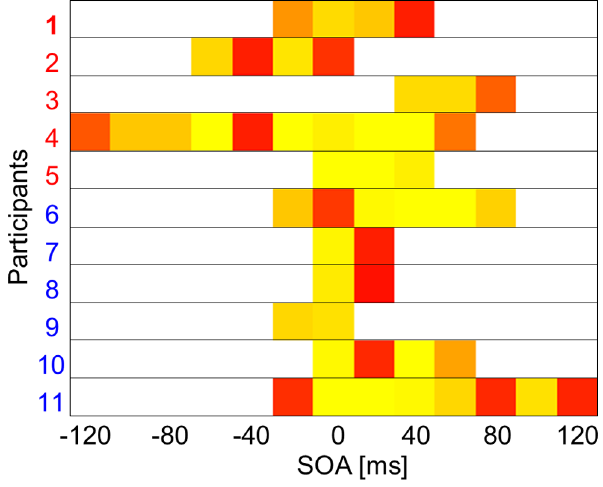
Figure 3. Race model violation in the reaction time task at the individual participant level. In this plot, each participant is represented by one line and each stimulus onset asynchrony (SOA) by one column. The p value for violation of the race model is color- coded for each participant and each SOA. Red color indicates p values closer to 0.05, yellow color indicates p values closer to 0. White color indicates that the race model could not be confidently rejected. Participant 1 (bold number) is the exemplary participant illustrated in Figure 5. None of the subjects displayed race model violation at SOAs beyond 2 120 ms and beyond + 120 ms. Participants 1 to 5 (red numbers) displayed task-induced TWI malleability, whereas Participants 6 to 11 (blue numbers) did